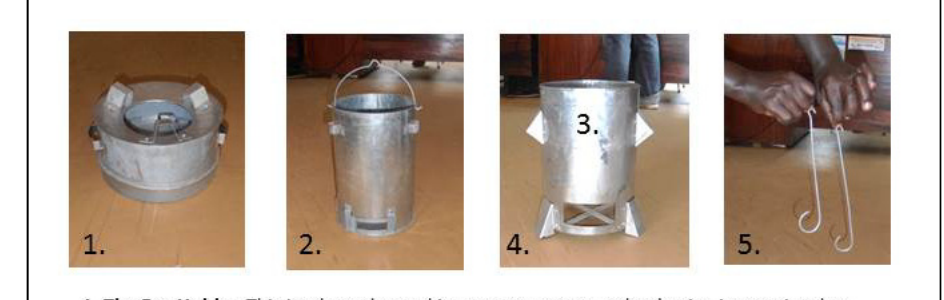
Figure 1. Top-lit updraft (TLUD) gasifier